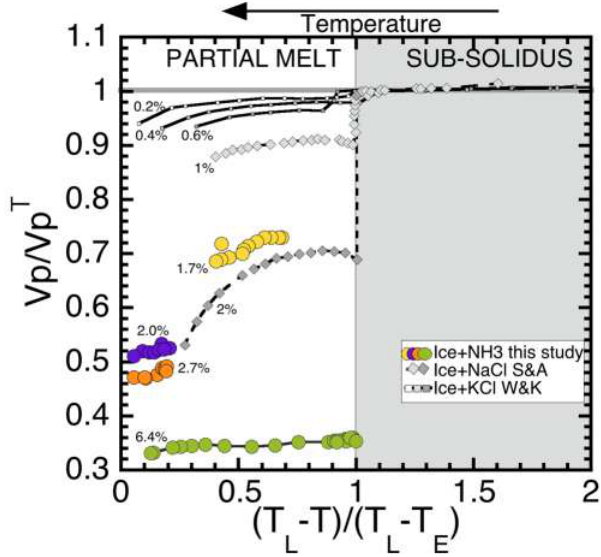
Figure 8. Normalized P-wave velocities versus normalized temperature for three different ice binary systems. T E for ice + KCl is 262.45 K; T L was estimated at 273, since reductions were only 0.1, 0.2, and 0.3 of a degree below T m [51]. T E for the ice + salt system is 251.85 K and T L was estimated as 272 and 271 at 1 wt % and 2 wt %, respectively [63]. T E for ice–ammonia is 175.4 K; T L was estimated at 272, 271, 270, and 262, for 1.7 wt %, 2.0 wt %, 2.7 wt %, and 6.4 wt %.